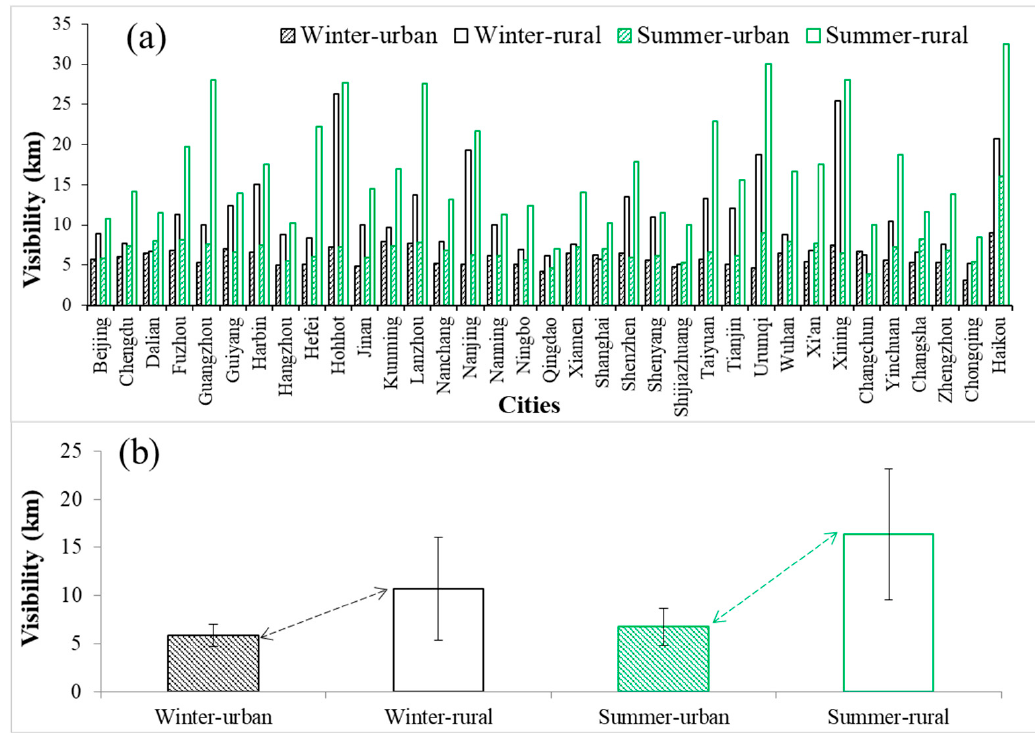
Figure 3. Wintertime (in black) and summertime (in green) mean visibilities (unit: km) calculated based on observational data from meteorological stations in urban (shaded bars) and rural (unfilled bars) areas of ( a ) each city and ( b ) all cities when the air is polluted. Data are from 2001 to 2015. Averaging over all cities, the wintertime urban mean visibility under polluted conditions is ~5.8 km (standard deviation, or std, = 1.1 km), and the wintertime rural mean visibility is ~10.7 km (std = 5.3 km). In the summertime, the urban mean visibility is ~7.0 km (std = 1.9 km), and the rural mean visibility is ~16.4 km (std = 6.8 km). The overall di ff erences in visibility between urban and rural areas are ~9.4 km and ~4.9 km for summertime and wintertime,